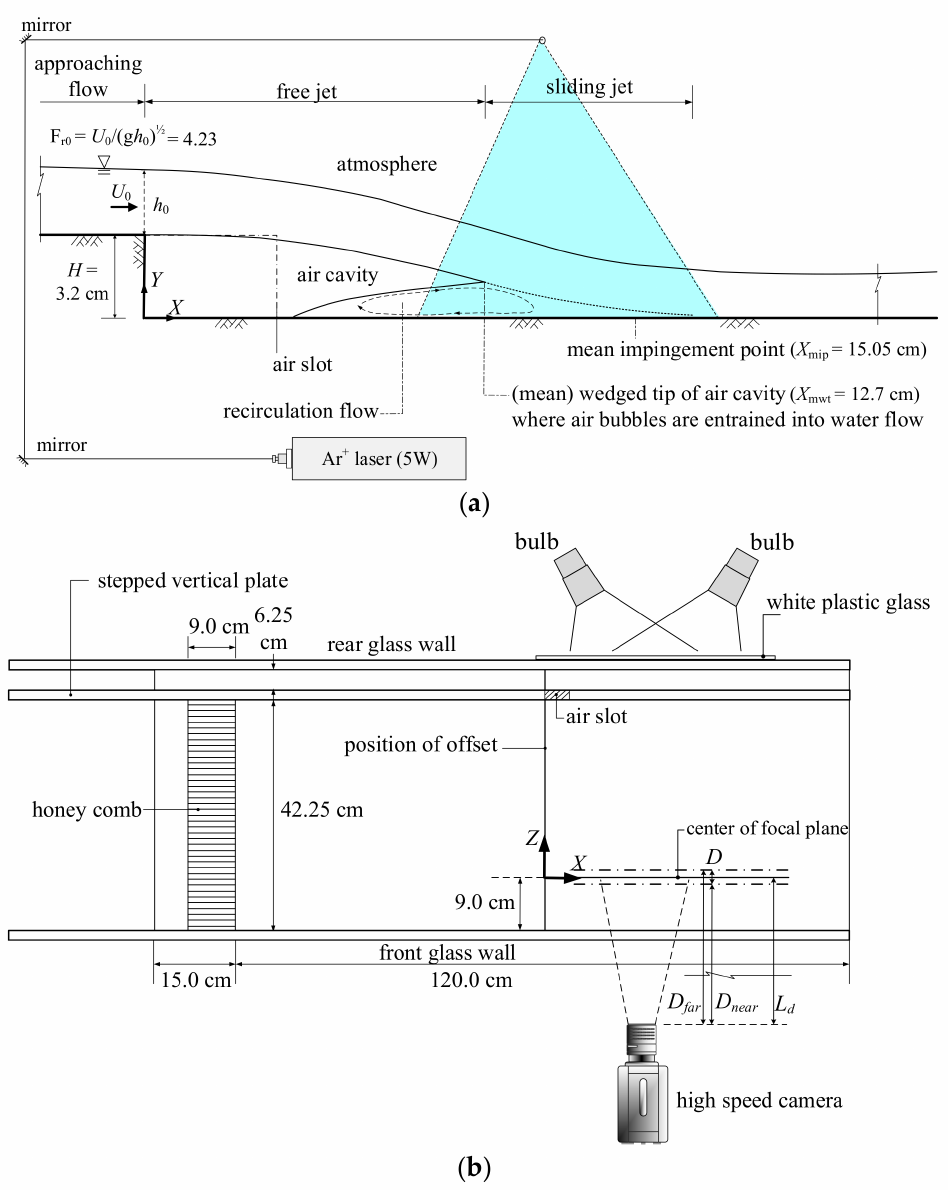
Figure 2. Schematic diagram showing ( a ) illumination of flow field using laser light sheet for HSPIV measurement; ( b ) deployment of the depth of field (with thickness D ) and two bulbs for SIM observation and BIV